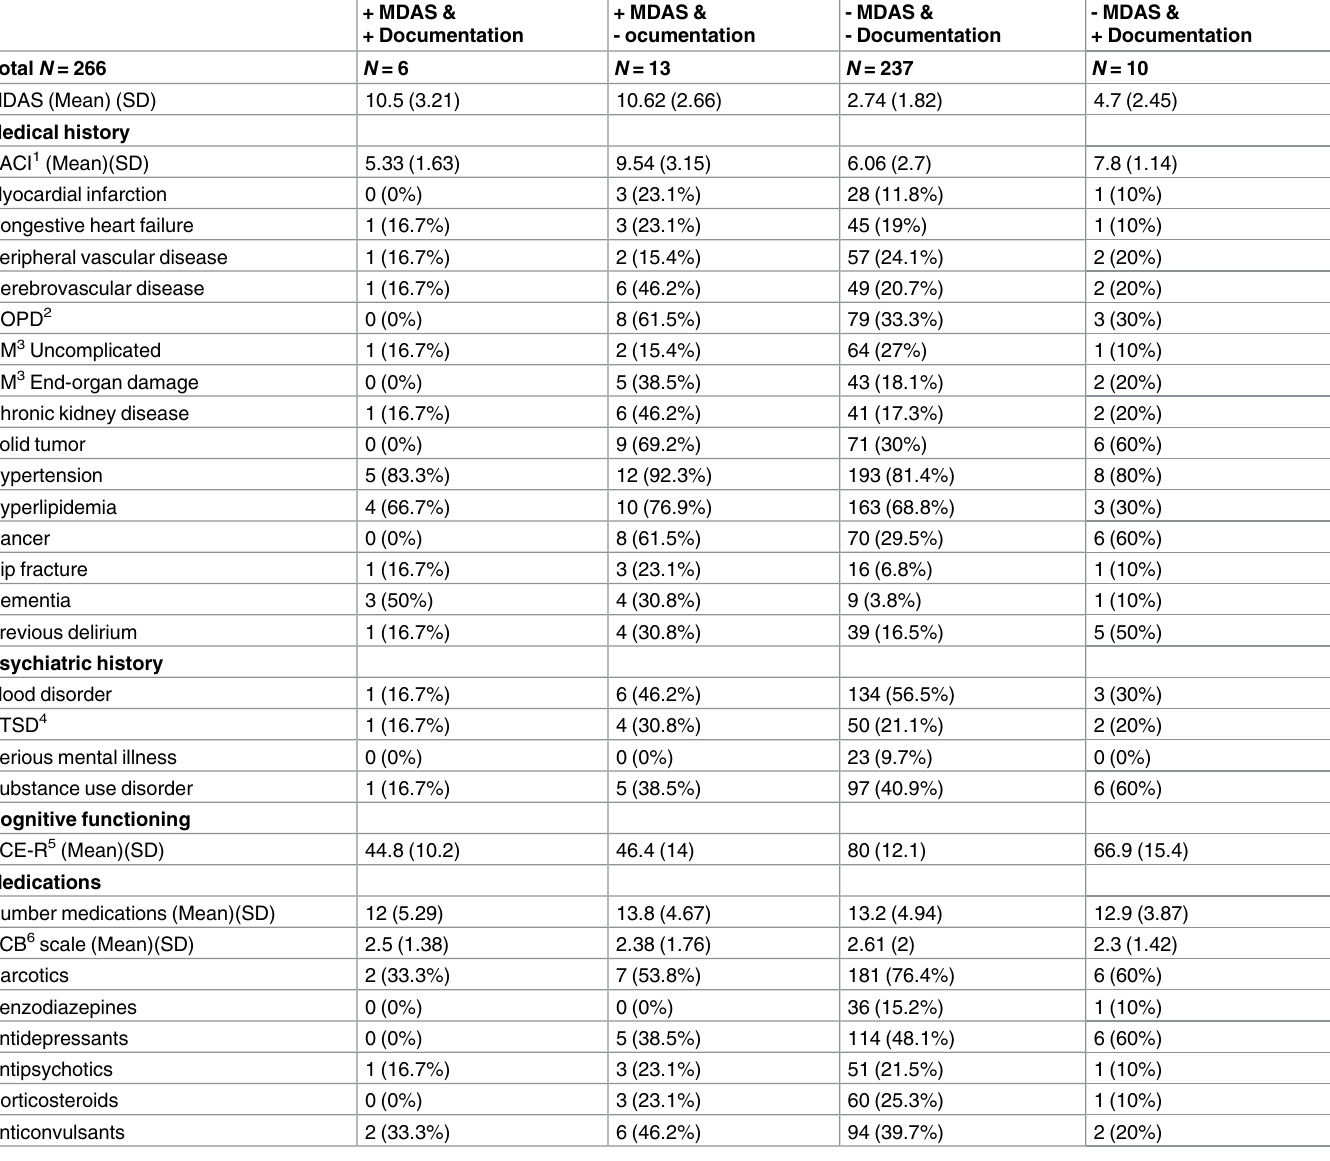
Table 1. Means and Standard Deviation (SD) and Frequencies of Medical and Psychiatric History, Cognitive Functioning, & Medication History According to Delirium